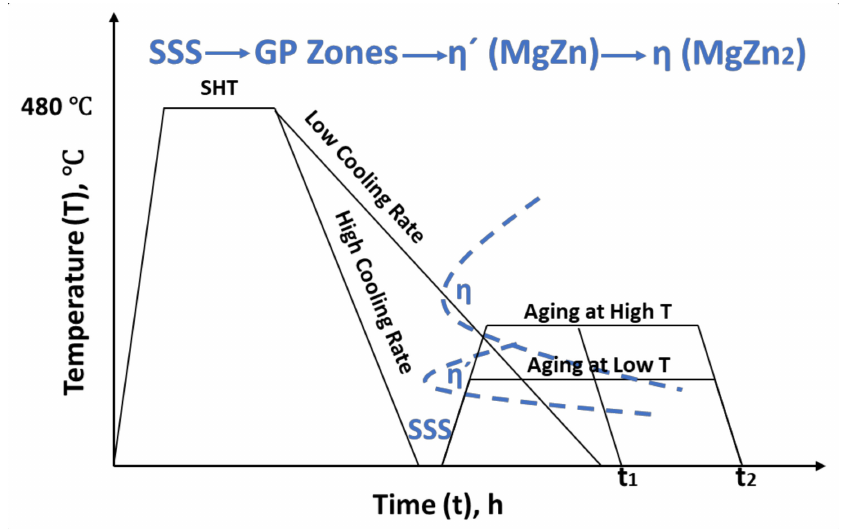
Figure 1. Precipitation sequence during artificial aging of EN AW 7075 alloy and schematic ranges related to nucleation of different precipitates with varying aging temperatures, durations and cooling rates from solution heat treatment (SHT) in EN AW 7075